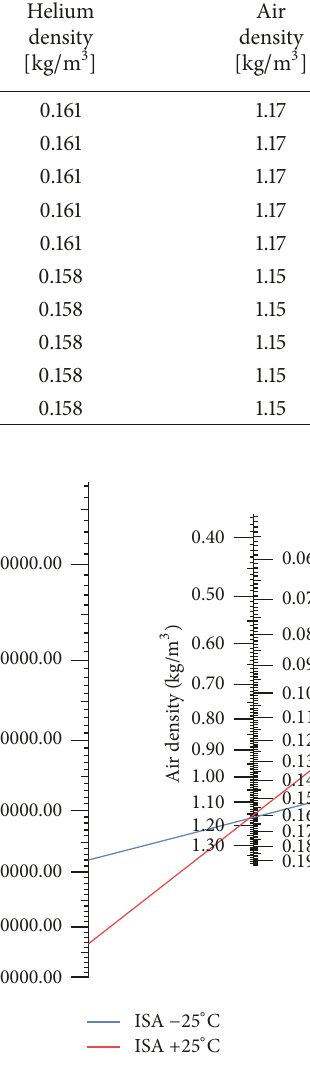
Figure 10: Air and helium densities in ISA − 25 ∘ C and ISA +25 ∘